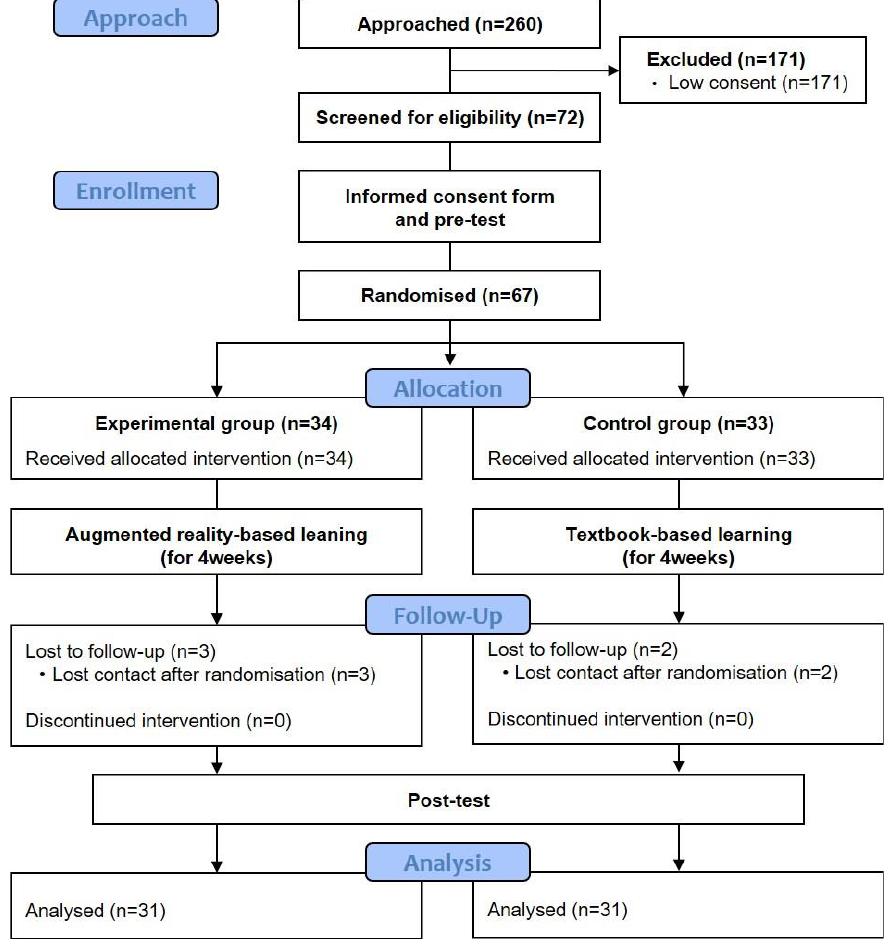
Figure 2. Study Flow Chart.